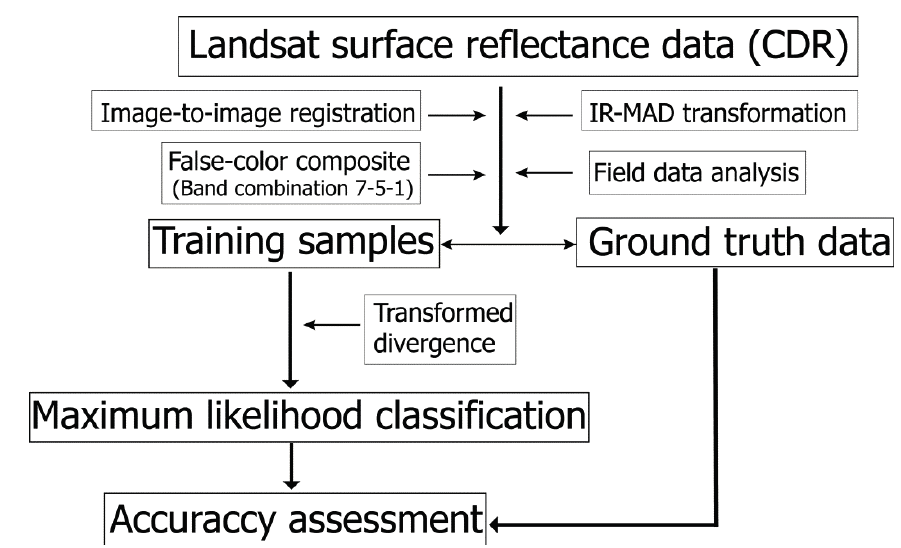
Figure 3. Flow chart for the Landsat images